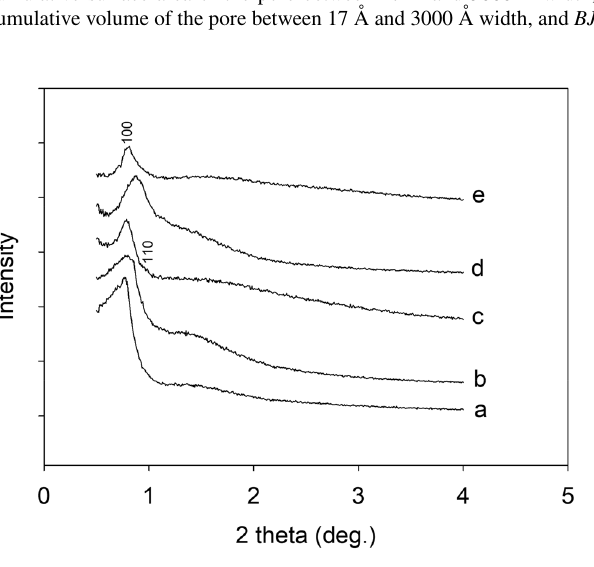
Fig. 5 Small-angle XRD patterns of the catalysts: a BC11.1, b BC5.7, c BC48, d BC0.7, and e BC27